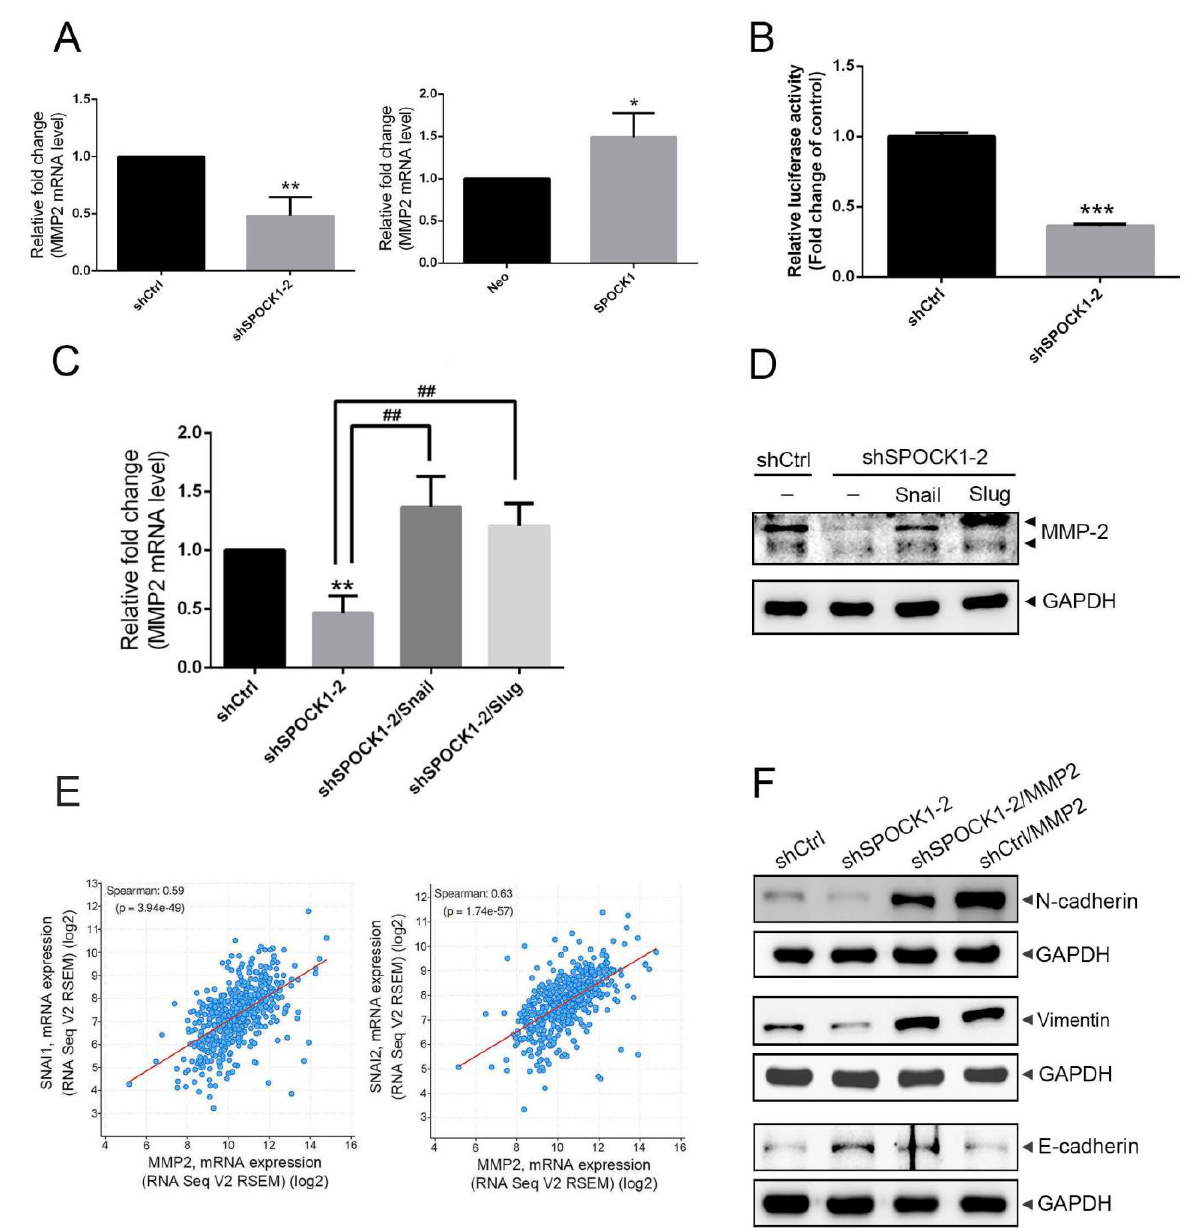
Caki-1-SPOCK1- and Caki-1-shSPOCK1-injected mice showed the upregulation and down- regulation of both proteins, respectively, compared to control mice (Figure 6D).